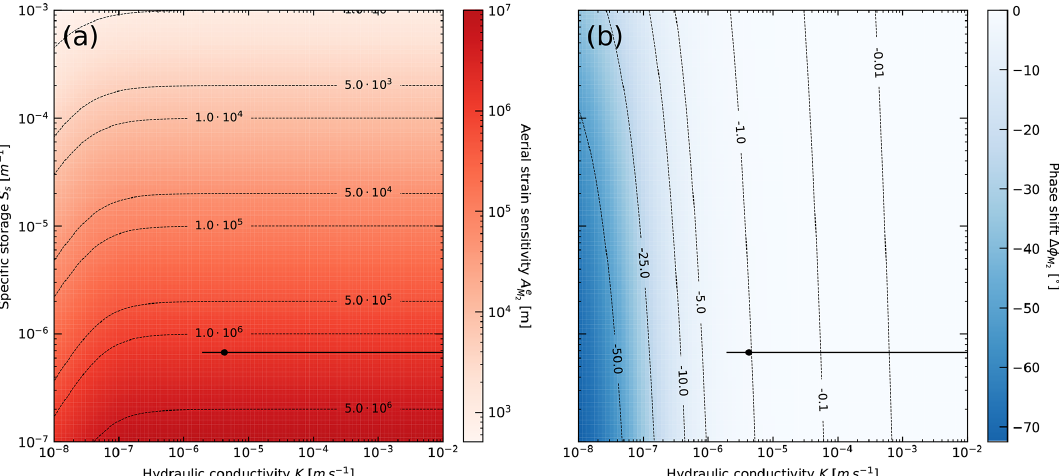
Figure 5. Well water level response to pore pressure for BLM-1 (well radius of 0.127m and length of 106m) and S 2 frequency (2.0 cpd). Black dots represent the results for this well found by least squares fitting of the amplitude and phase response to the analytical solutions by Hsieh et al. (1987). The horizontal and vertical (not visible) black lines depict the property ranges as a result of uncertainties in the aerial strain sensitivity and phase difference.